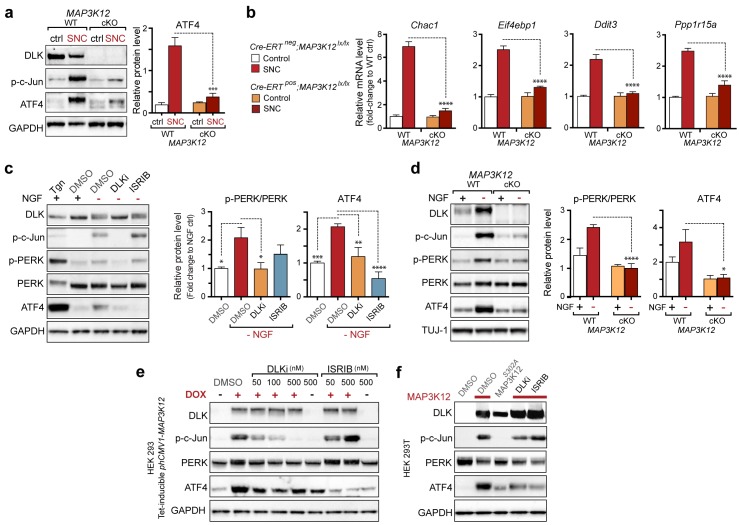
DLK is necessary and sufficient for PERK activation.(a–b) DLK-deficient (CAG-ERTpos;Map3k12lx/lx, DLK cKO) mice exhibit reduced activation of the ISR and JNK pathways following SNC compared to controls (CAG-ERTneg;Map3k12lx/lx). (a) Activation of ATF4 is reduced in DLK cKO L3/L4 DRGs 24 h after SNC (n = 3/condition). (b) qRT-PCR of ISR-associated genes in L4 DRG following SNC in DLK cKO mice compared to controls (n = 4/condition). (c) Inhibition of DLK (DLKi, 500 nM) reduces p-PERK and ATF4 induction, in addition to p-c-Jun, compared to DMSO vehicle controls following NGF-withdrawal in primary DRG cultures. ISRIB (500 nM) treatment specifically reduces ATF4 upregulation. (n = 6/condition, aggregated data from four independent experiments). Thapsigargin (Tgn, 100 nM) provides a positive control for PERK activation. (d) Primary DRG cultures deficient in DLK (DLK KO) lack activation of PERK and ATF4 following NGF deprivation (n = 4/condition). (e) Doxycycline (DOX)-inducible DLK expression in stably-transfected HEK293 cells activates PERK (assessed by molecular weight shift, as anti-p-PERK does not recognize human p-PERK) and ATF4, which can be blocked by DLKi or ISRIB treatment. (f) Transient transfection of mouse wildtype DLK, but not kinase dead DLK-S302A control, in HEK293T cells activates the ISR. One-way ANOVA with post-hoc Bonferroni was used for statistical comparisons. *p<0.05, **p<0.01, ***p<0.001, ****p<0.0001.